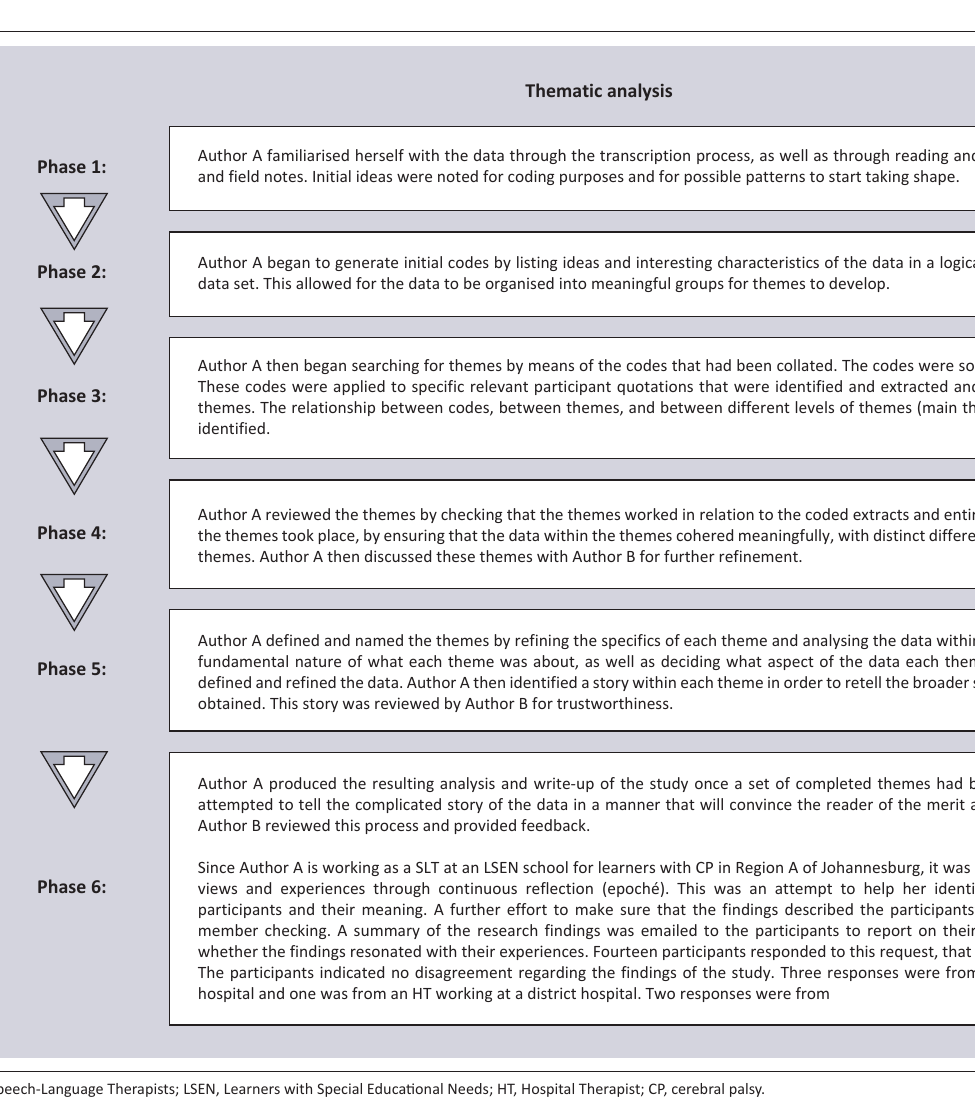
FIGURE 1 : Thematic analysis as proposed by Braun and Clarke